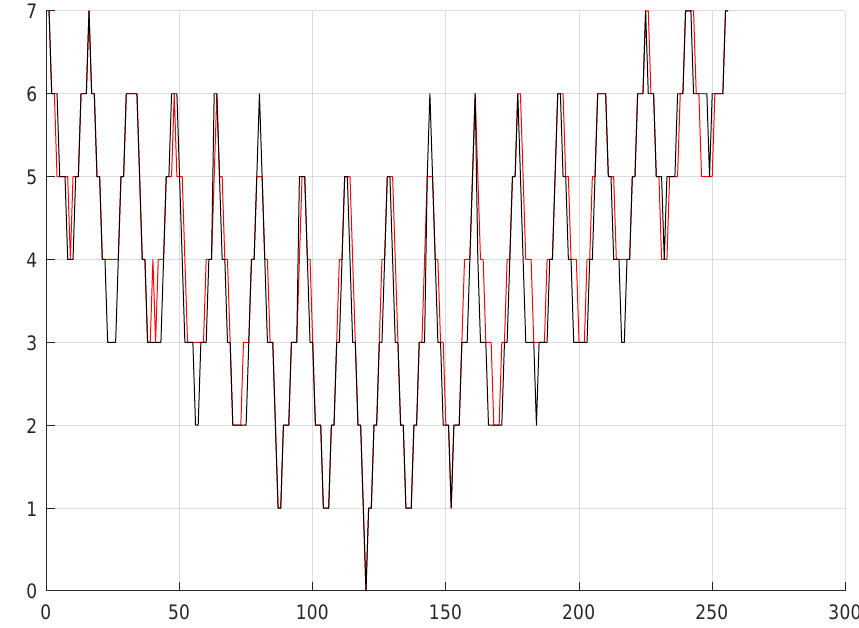
Figure 10. x -coordinate is the codes of all nodes, and the 120th node is the station. y -coordinate is the hops or distance from nodes to the station. The black curve is the estimated node hop curve after fitting and the red curve is the universal node